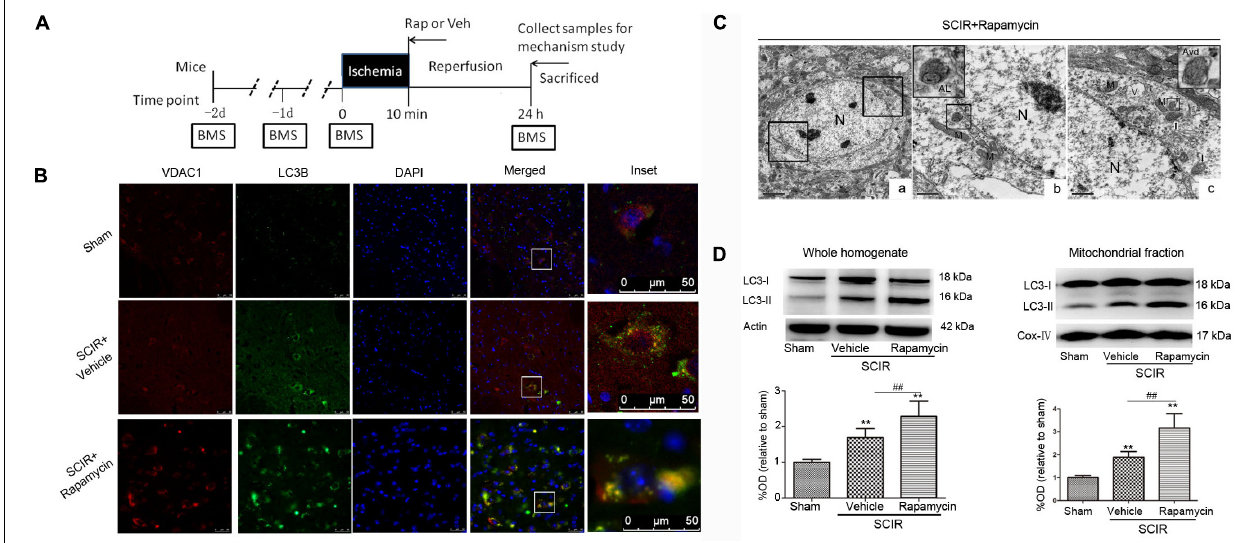
FIGURE 1 | Rapamycin treatment enhanced mitophagy after spinal cord ischemia-reperfusion injury. (A) . Schematic diagram of the experimental design. Experimental groups were treated with vehicle and rapamycin (intraperitoneal injection, 1mg/kg). Mice received treatmetn at reperfusion onset and were sacrificed at 24 h after SCIRI. (B) Immunohistochemical localization of VDAC1 (mitochondrial marker) and LC3B (autophagy marker) co-staining in spinal cord at 24 h after SCIRI. VDAC1 (red), LC3B (green). The inset images represent higher magnification of the boxed area in the corresponding merged images. (C) . Electron micrographs demonstrating neuron mitophagy structure in rapamycin-treated SCIRI mice. Autophagic vacuoles, autolysosomes (AL), typical mitophagy structure and swollen mitochondria (black arrow)were observed in neurons. High magnifications in (b) revealed a typical autolysosomes structure. High magnifications in (c) revealed a typical mitophagy structure, that is a degradative autophagic vacuole (Avd) including a partially degraded mitochondrial. (b) is the high magnification of lower-left box in the figure C-a and (C) is the high magnification of upper-right box in the figure C-a . M-mitochondrial, N-nuclear, V-vacuole. scale bar = 0.5 µ m or 2 µ m. (C) Representative western blots and quantitative graphs demonstrate the expression of LC3-I /LC3-II in the whole homogenates at 24 h after SCIRI. (D) Representative western blots and quantitative graphs demonstrate the expression of LC3-I and LC3-II in the mitochondrial fractions at 24 h after SCIRI. Data were shown as mean ± SD, n = 6. ∗ p < 0.05, ∗∗ p < 0.01 vs. Sham; # p < 0.05, ## p <